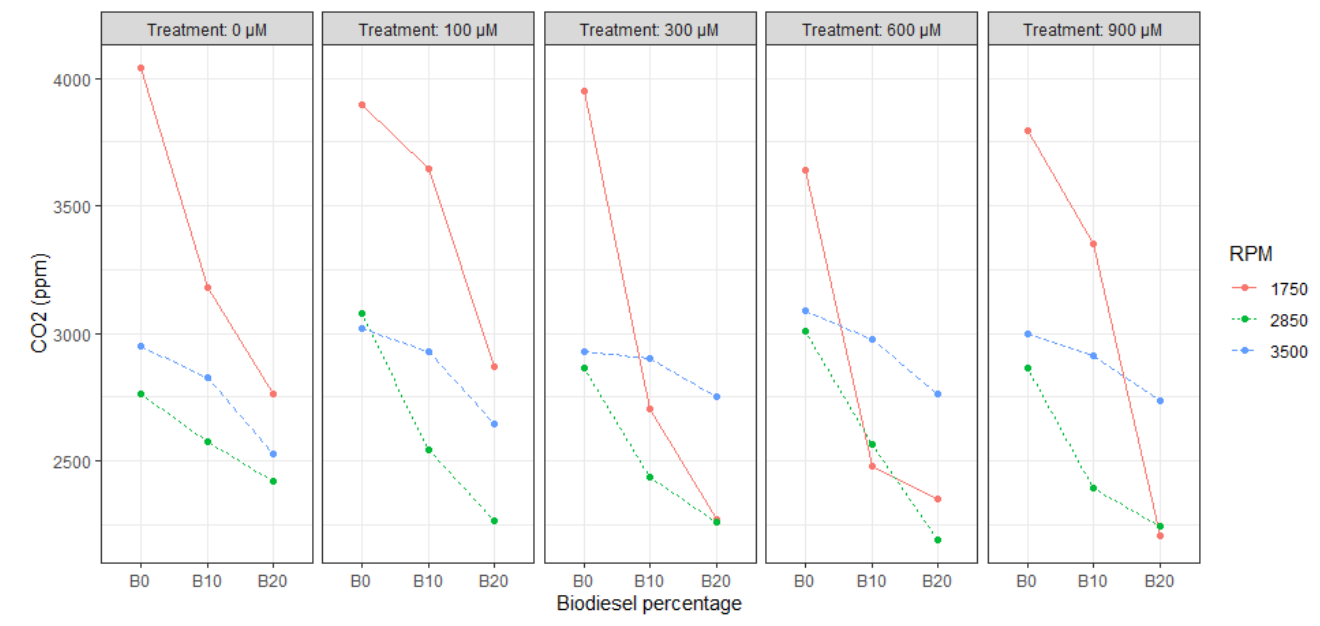
Figure 3. Correlation plot between CO 2 , SA content, RPM, and biodiesel percentage.